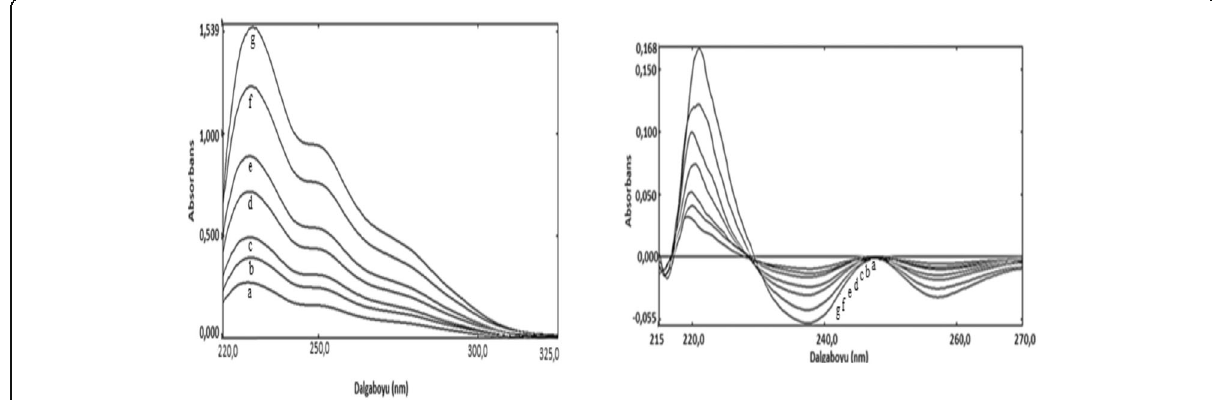
Fig. 4 Direct UV and first derivative UV spectrum of ( a ) 6.0 μ g mL − 1 , ( b ) 8.0 μ g mL − 1 , and ( c ) 10.0 μ g mL − 1 , ( d ) 14.0 μ g mL − 1 , ( e ) 18.0 μ g mL − 1 , ( f